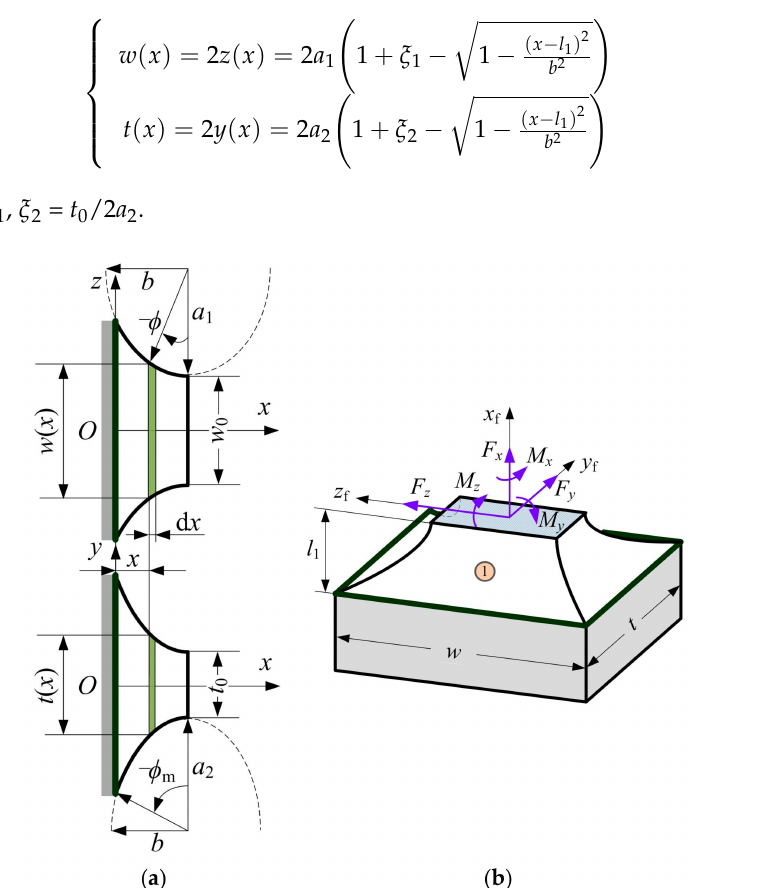
Figure 6. Left half-segment two-axis elliptical-arc flexure hinge: ( a ) Geometric parameters defining two non-identical symmetric elliptical-arc profiles; ( b ) Three-dimensional